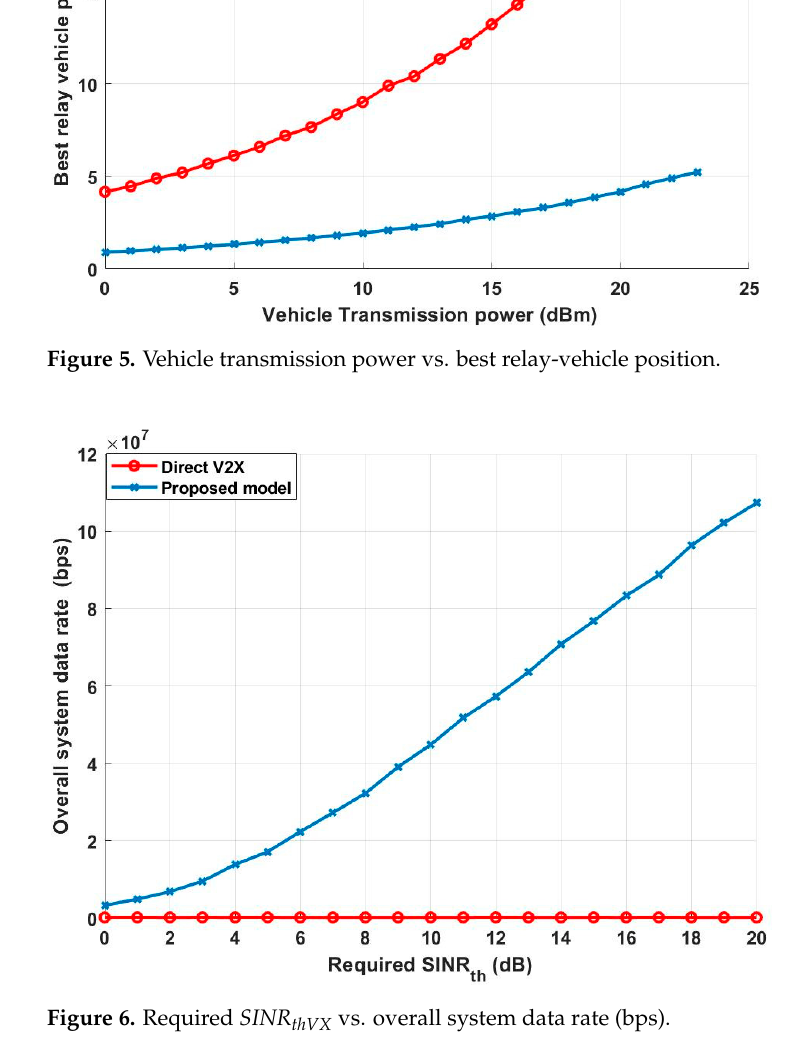
Figure 5. Vehicle transmission power vs. best relay-vehicle position.